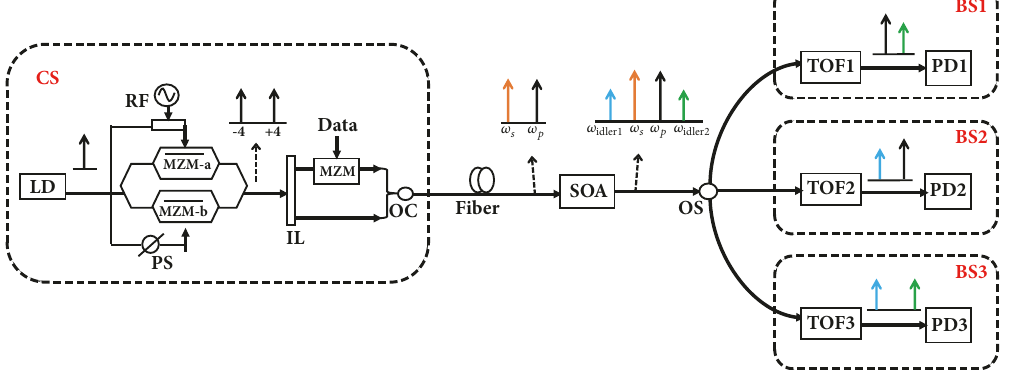
Figure 1: The principle of multiple-frequency optical mm-wave signals generation using DP-MZM and FWM in SOA for ROF system LD: laser diode, MZM: Mach-Zehnder modulator, OC: optical coupler, OS: optical splitter, SOA: semiconductor optical amplifier, TOF: tunable optical filter, and PD: photodio.